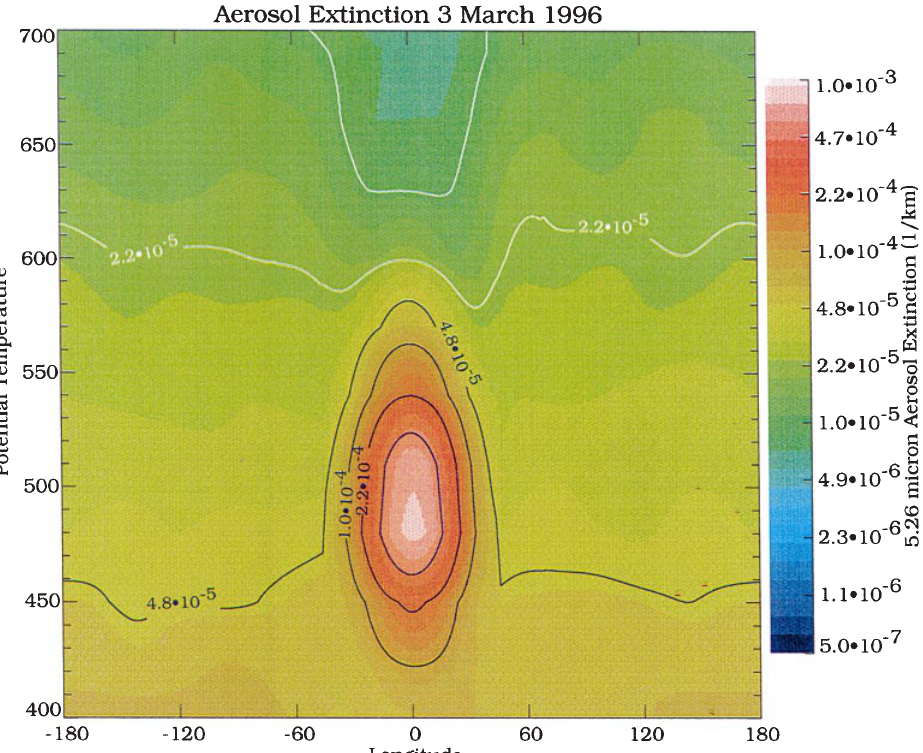
Fig. 19. HALOE measurements of aerosol extinction (5.26 l m) in km (cid:255) 1 at 52 (cid:14) N on March 3, 1996